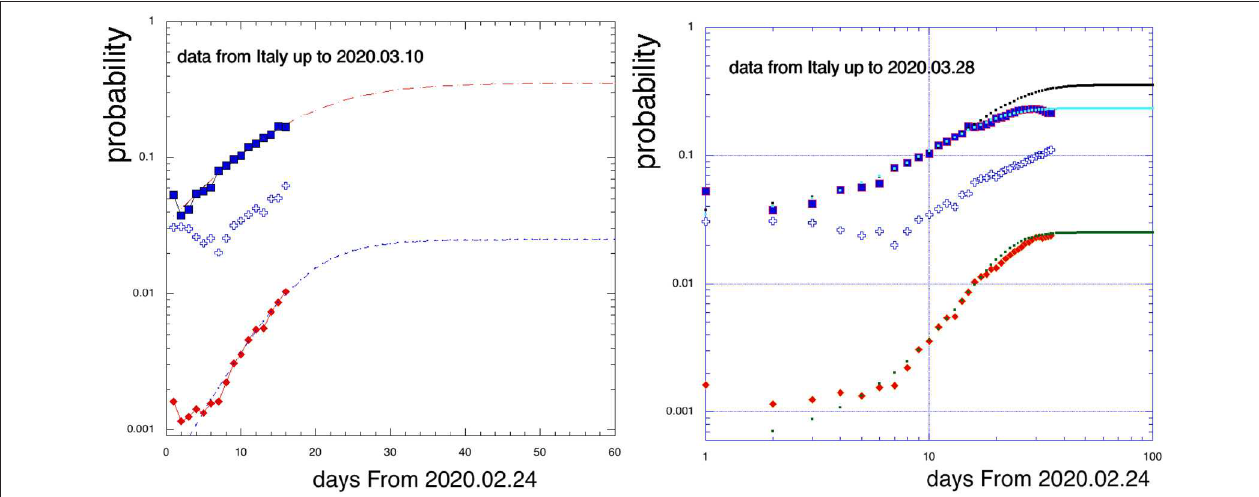
FIGURE 4 | Infection probability (number of positives divided the total number of tested, full squares) and death probability (deceased/total, rhombs) as function of time (days) (from February 24, 2020). The open crosses give the number of deceased DIVIDED by the number of positives. The asymptotic value should be reached on March 24, 2020 (left panel). The right panel includes the last days after the exceptional measures (March 10) were announced by the Italian government. The probability to be infected went down from 35% (left panel) to 23% (right panel). A small decrease is observed for the deceased (lower